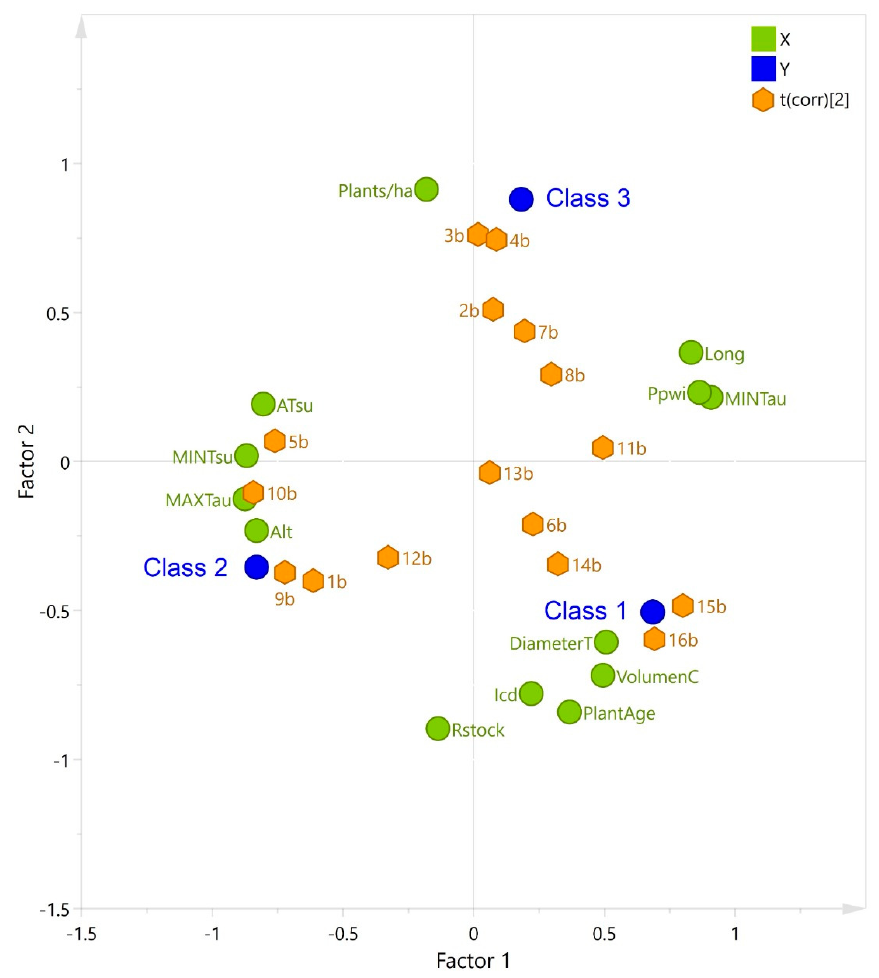
Figure 6. Biplot of the partial least squares discriminant analysis of predisposing factors associated with the incidence of branch canker and dieback in the sixteen orchards prospected in this study in the 2015 season. Scores (orange hexagons) are shown for the sixteen orchards (16 observations (b)). Loadings are shown in green circles. Factors = 3; R 2 Ycum = 85.4%; Q 2 Ycum = 72.0%. Class = 3; Class